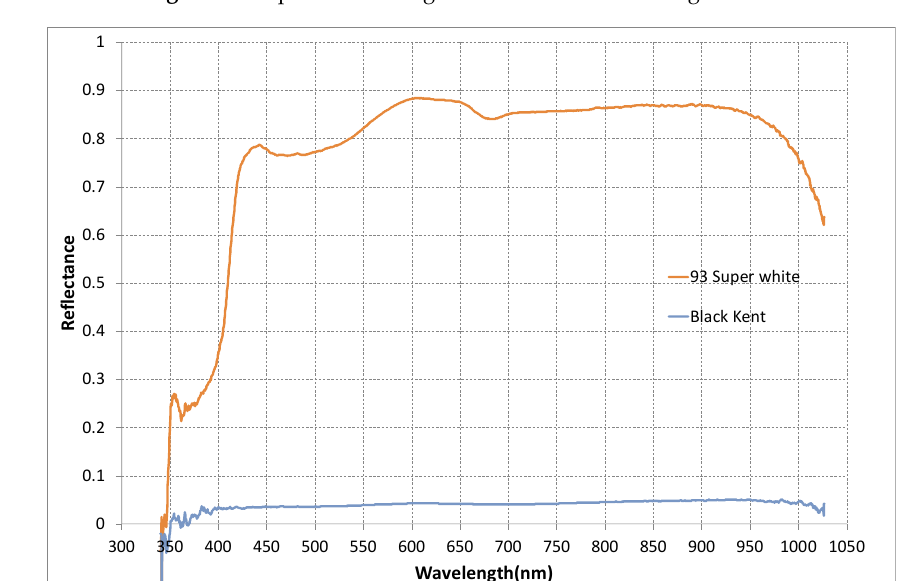
Figure 13. The reflection ratio of the white and black paper used on the test